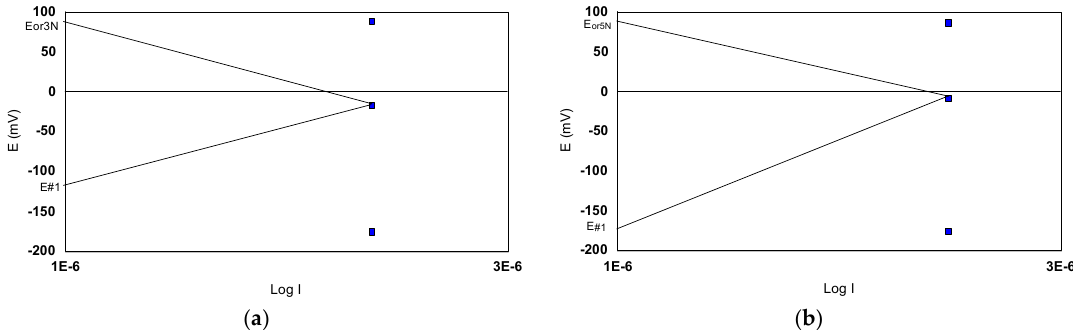
Figure 14. Evans diagrams drawn for studied steel/gold couplings. ( a ) Coupling #1/3N; ( b ) Coupling #1/5N.